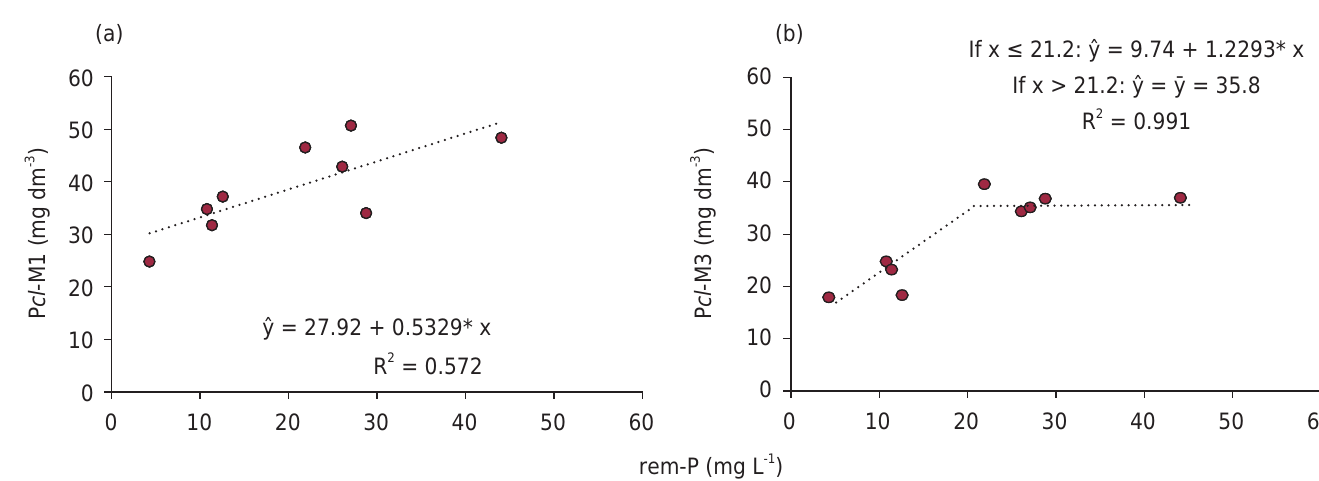
Figure 3 . Soil P critical levels by a) Mehlich-1 (P cl -M1), and b) Mehlich-3 (P cl -M3) as a function of remaining P (rem-P) in nine soil samples cultivated with corn. *Significant at 5